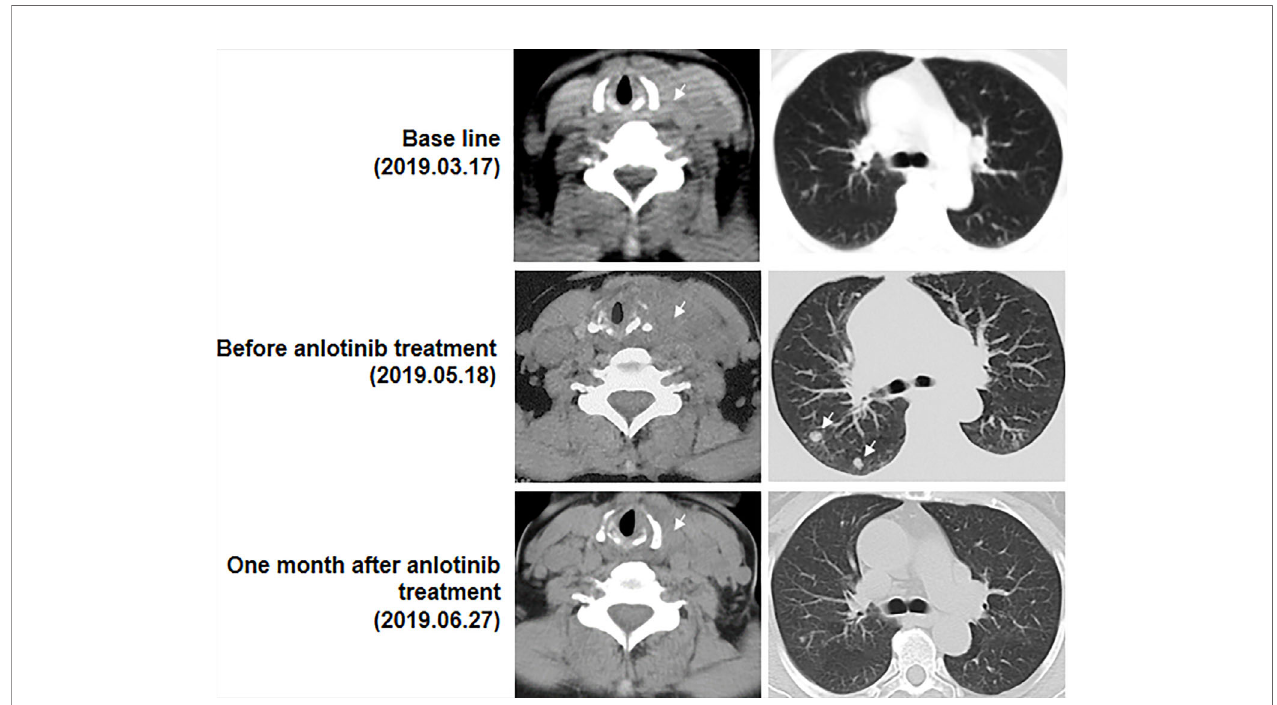
FIGURE 3 | Computed tomography images (CT) of the thyroid and lung before and after anlotinib treatment. Arrows represent the masses. At base line, in addition to brain lesions, there were a mass in the left thyroid and some opaque mottled shadows and pulmonary nodules in the lung. Then the patient experienced brain surgery. Before anlotinib treatment, a huge mass in the left thyroid and two obvious pulmonary nodules was found. One month after anlotinib treatment, the pulmonary nodules were found to be controlled, thyroid tumor drastically reduced and tracheal compression